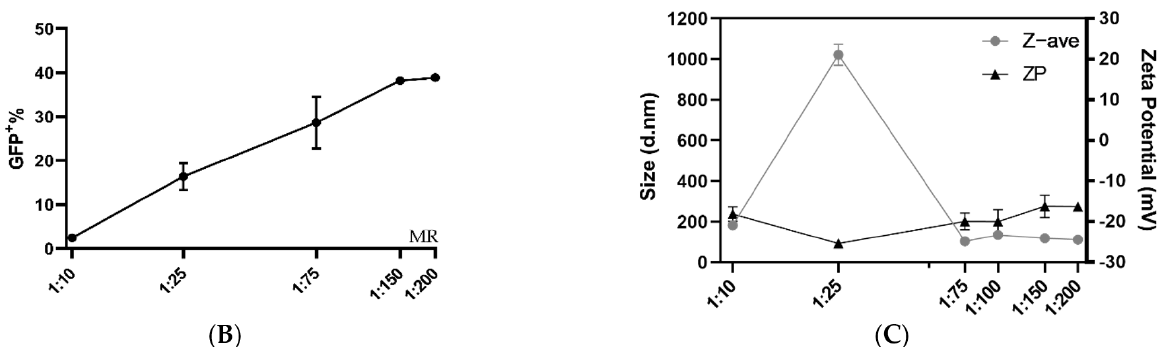
Figure 1. Overview of the experimental setup and PF14 delivery of Cas9 RNP to reporter cells. ( A ) Outline of the general experimental setup. 1. PF14 is complexed with Cas9 RNP and added to cells. 2. The PF14 enables RNP to escape into the cytoplasm, where the nuclear localization signal relocates the RNP to the nucleus, where it cleaves the DNA in the SL construct. 3. The cells are incubated for 72 h after transfection and then analyzed by flow cytometry. ( B ) Flow cytometry results from the HEK293T SL cells treated with the 200 ng Cas9 RNP complexed with PF14 in increasing MR (RNP: PF14). The complexes were formed in HBG buffer. n = 3. ( C ) Size and zeta potential of the HBG-formulated RNP: PF14 complexes in increasing MR, as analyzed by